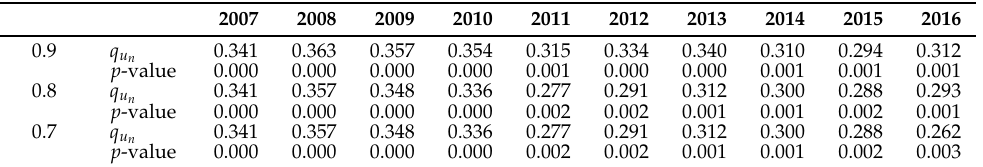
Table 13. The TQCC estimation between RCI (based on a 5-year rolling window) and carbon efficiency from 2007 to 2016 with uq = 0.9, 0.8 and 0.7.